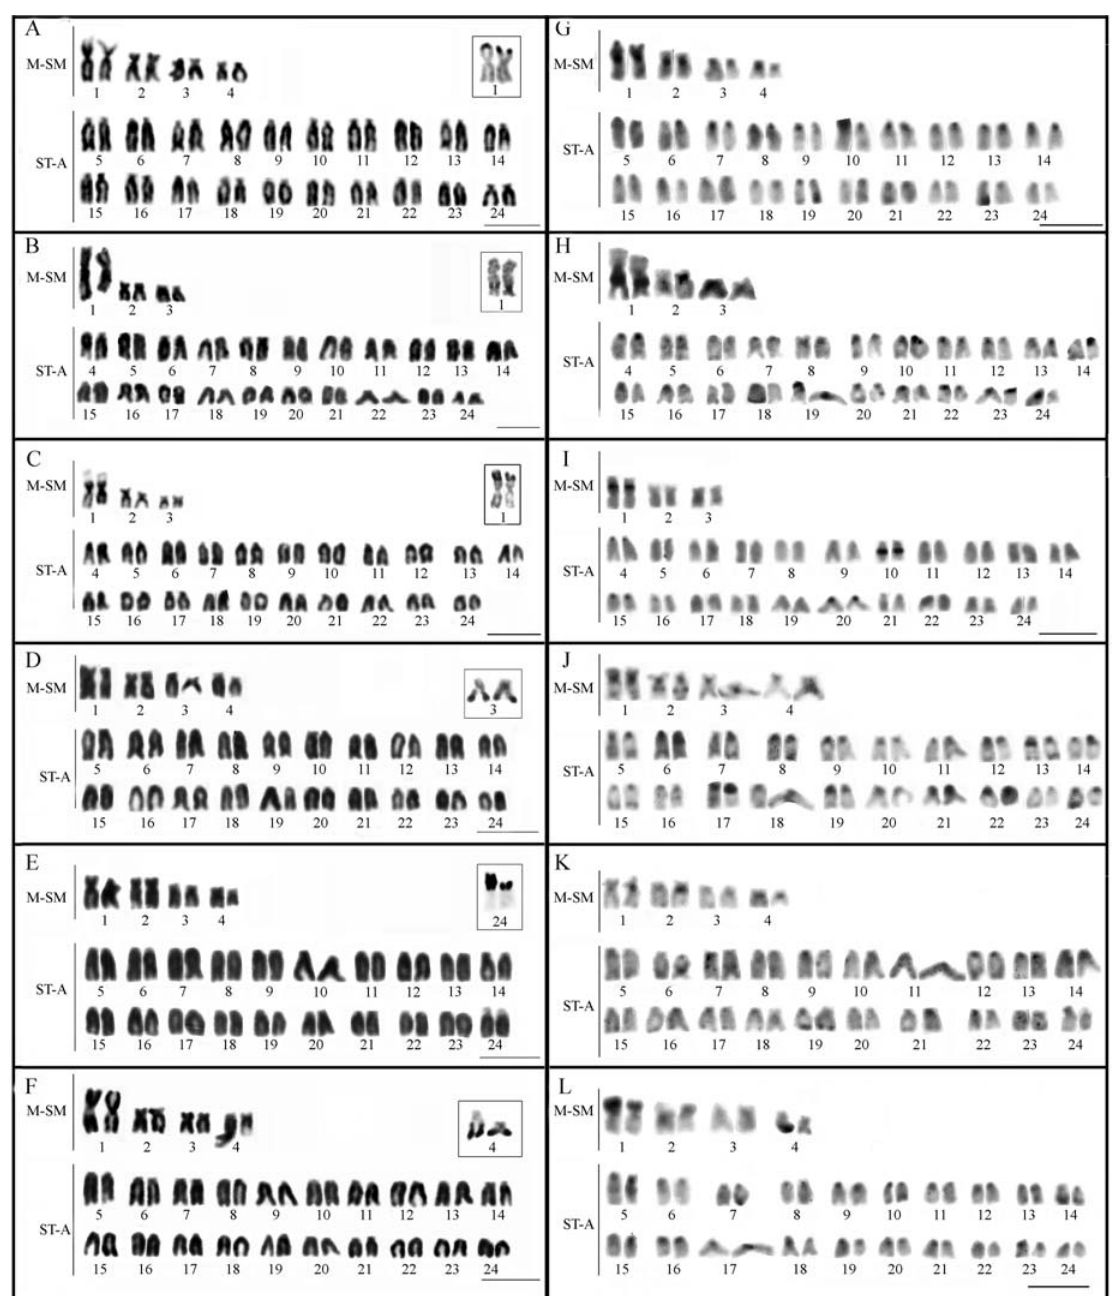
Figure 1 - Conventional Giemsa-stained and C-banding karyotypes of: (A and G) C. cincta ; (B and H) C. inpa ; (C and I) C. reticulata ; (D and J) C. lugubris ; (E and K) C . cf. johanna ; and (F and L) C. britskii. In evidence, Ag-NORs pairs. Bar represents 10 μ